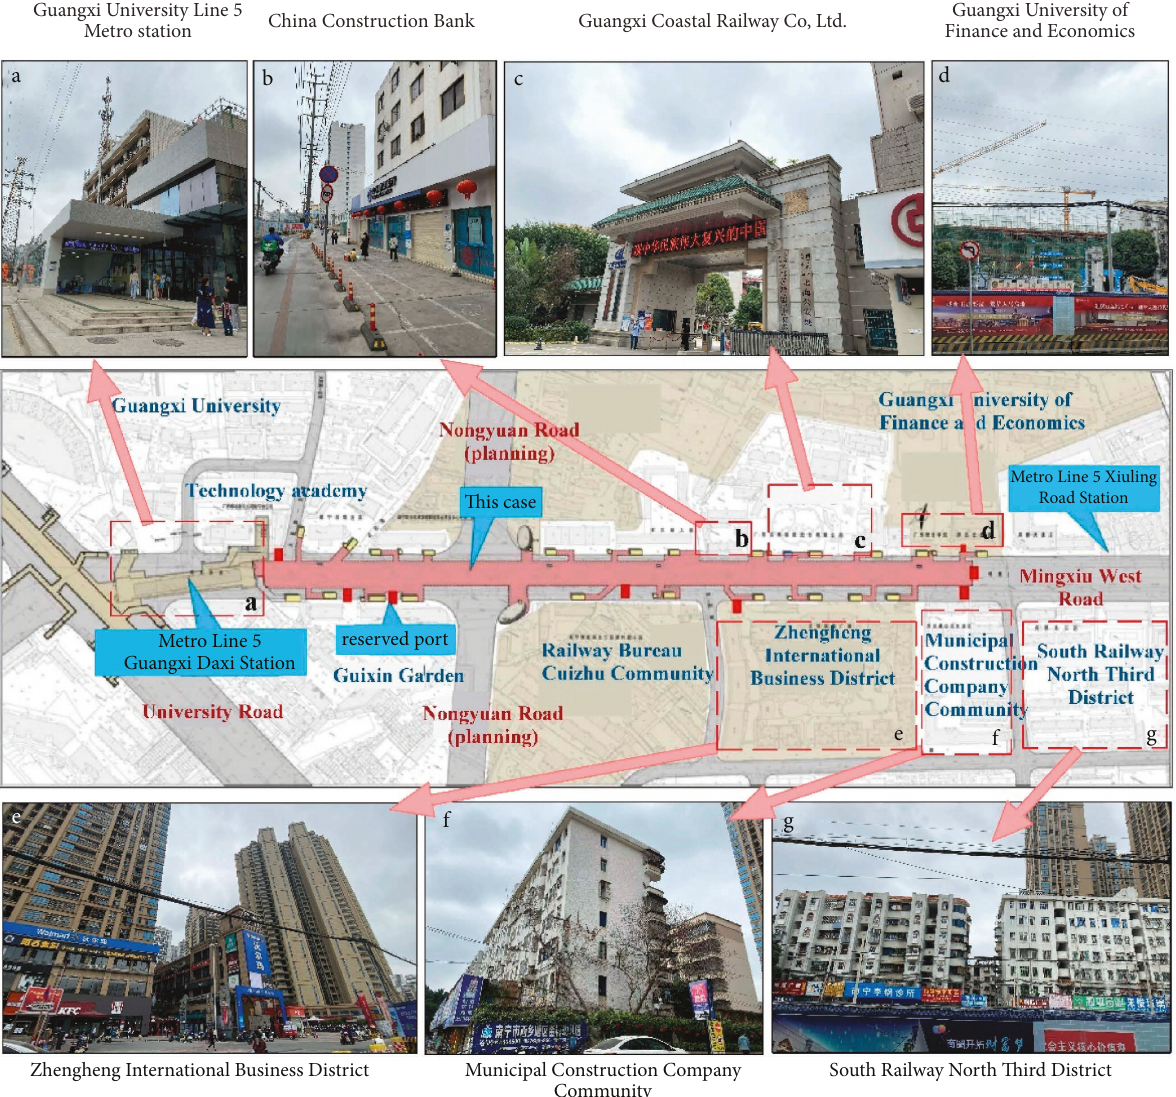
Figure 3: The surrounding buildings and environment of the underground project of Guangxi University of Finance and